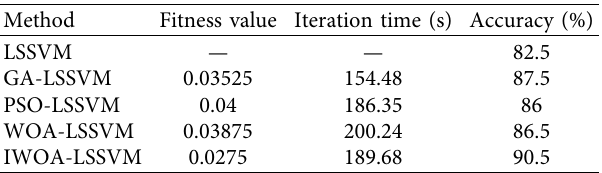
Table 7: Performance comparison of different optimization methods.